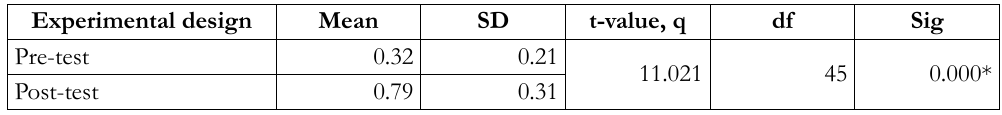
Table 8. Paired Sample t-test Analysis (Pre-and-Post tests) of the Problem Solving Skills of the PBL Group